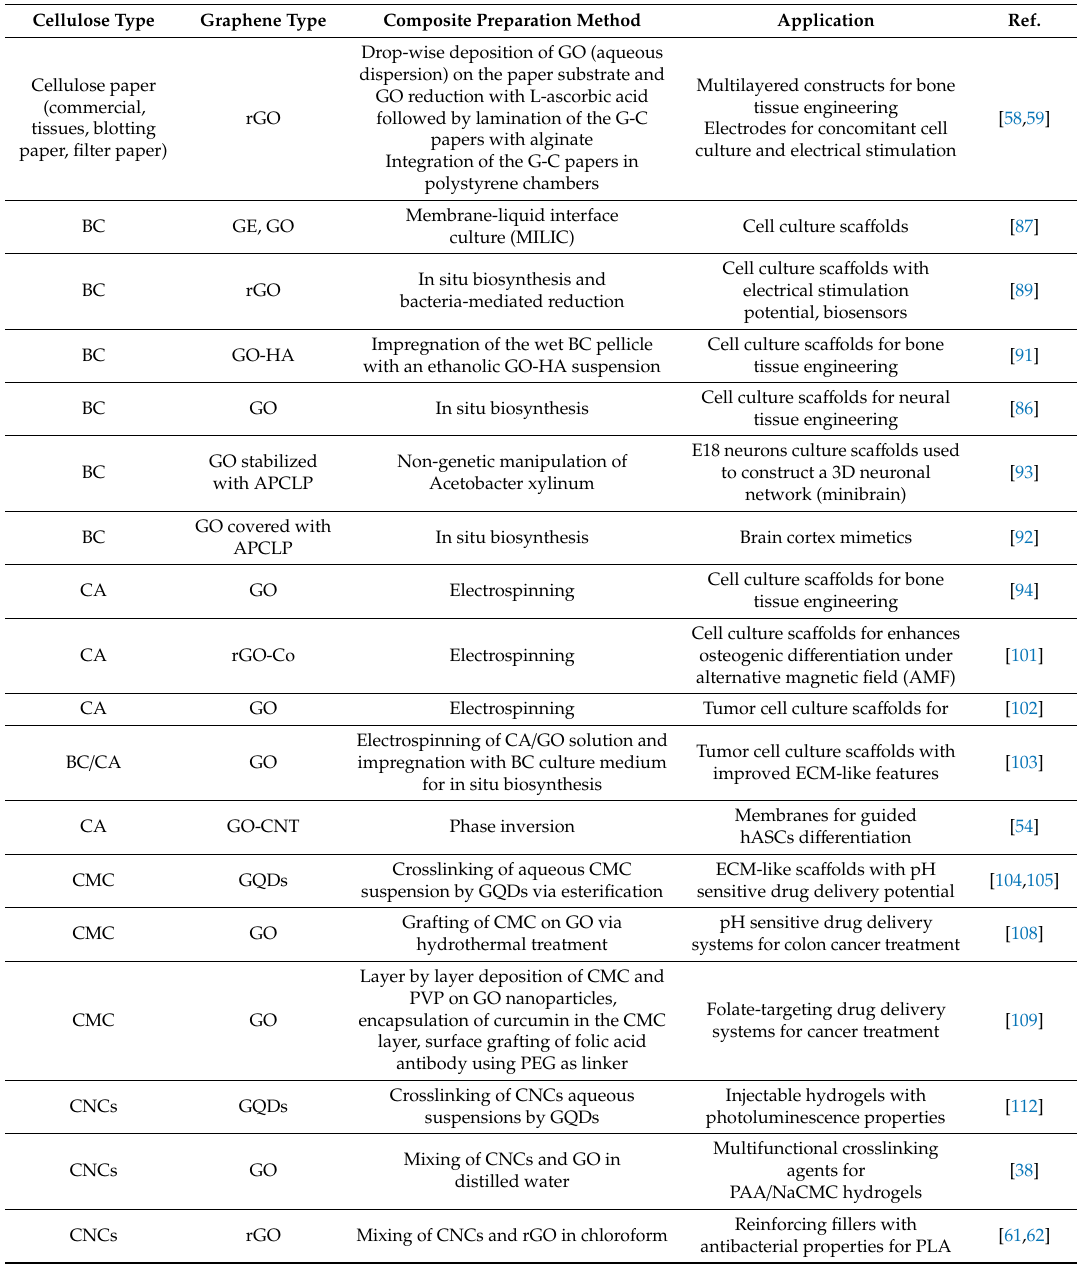
Table 1. Components, preparation methods and applications of the cellulose / graphene composites presented in this